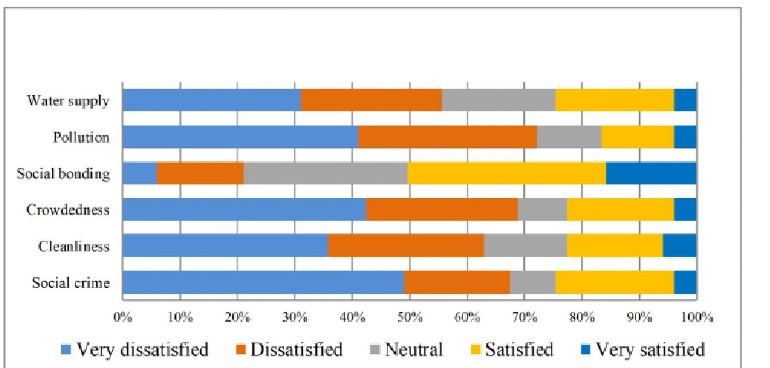
Fig 2. Satisfaction with social environment. Source: Authors’ compilation, 2019.